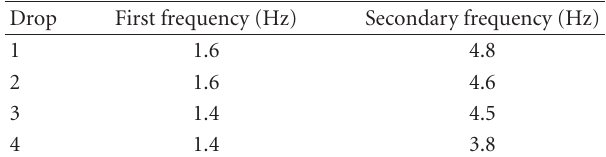
Table 4: Oscillation frequencies of the beam under the four direct impacts measured by Ground-based microwave radar interferome-